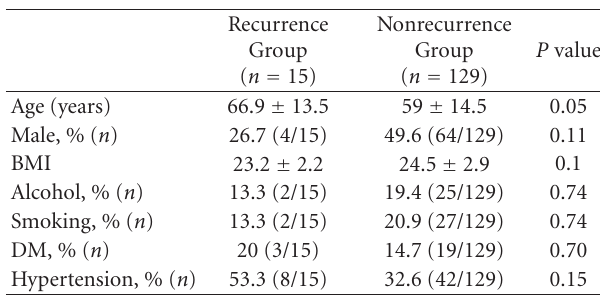
Table 1: Patient characteristics.